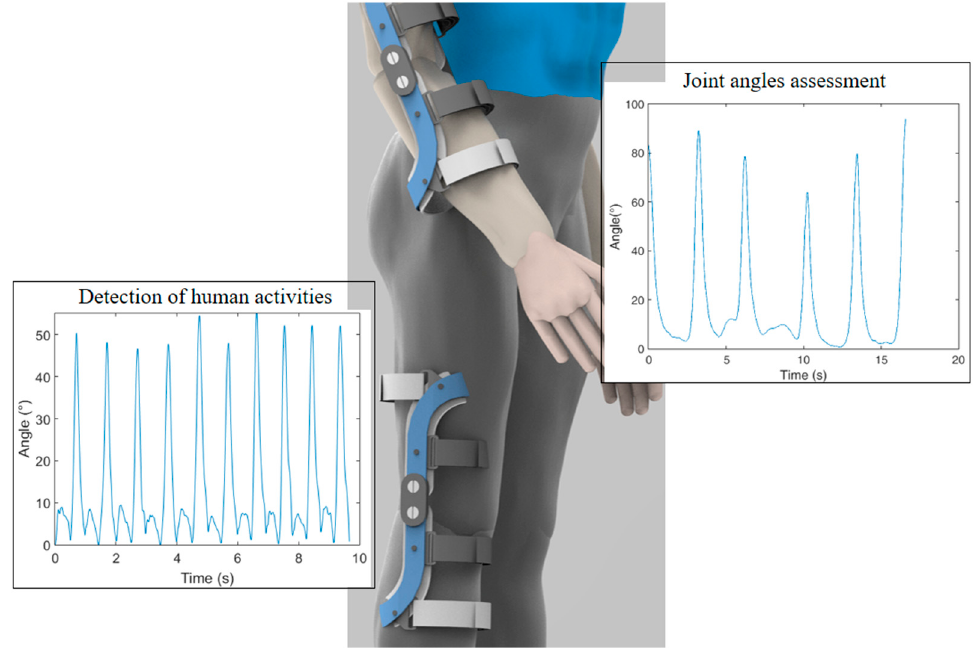
Figure 8. POF sensors applications on human movement.